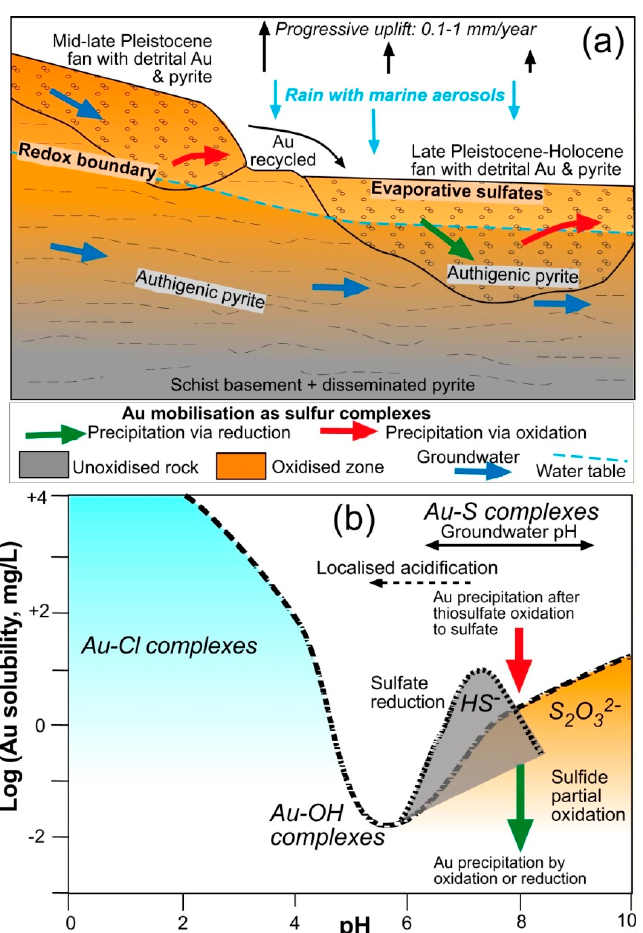
Figure 10. Summary diagrams highlighting the key features of biologically-mediated authigenic gold mobility in Late Pleistocene alluvial fans on the flanks of tectonically active antiformal ranges (Figure 1a,b). ( a ) Sketch cross section through a portion of the sedimentary veneer as indicated in Figure 2a, showing the fluctuating redox boundary that controls oxidised and reduced gold mobilisation processes (see text); ( b ) Variations in gold solubility with pH in near-surface groundwater, for differing redox conditions as in a (modified from [19], from references quoted in text).